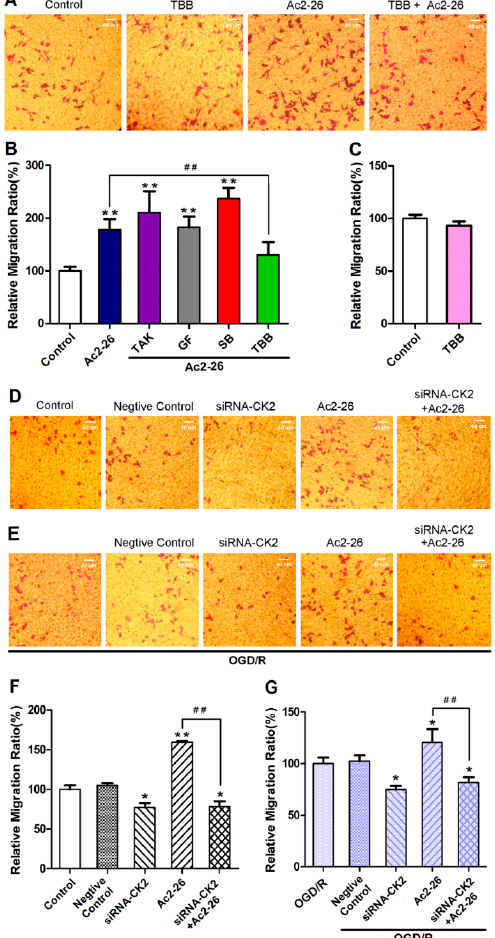
Figure 9. CK2 (casein kinase II) is involved in Ac2-26-mediated BV-2 cell migration. ( A , D , E ) Photographs illustrating the effect of TBB and the small interfering RNA (siRNA)-CK2 sequence on BV-2 cell migration in trans-well migration assays. Photographs were taken from the lower sides of the chamber’s membrane; the violet particles represent cresyl violet-stained BV-2 cells; ( B , C , F ) the relative migration ratio in different groups as a percentage relative to the control group; ( G ) the relative migration ratio in different groups as a percentage relative to the oxygen–glucose deprivation/reperfusion (OGD/R) group. The siRNA sequence was used to inhibit CK2 expression. The final concentration of drugs were as follows: Ac2-26, 1.32 µ M; TBB, 40 µ M; GF, 2 µ M; TAK, 1 µ M; SB, 0.1 µ M. All data are expressed as the mean ± standard error of the mean (SEM) ( n = 5–9). * p < 0.05, ** p < 0.01 (compared to the first group), ## p < 0.01. Scale bar: 40 µ